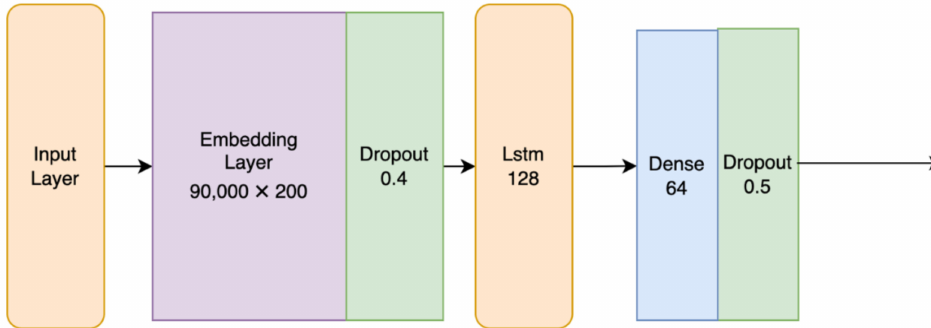
Figure 6. Recurrent neural network architecture. Table 2. Extracted Features with the Corresponding Description. Feature